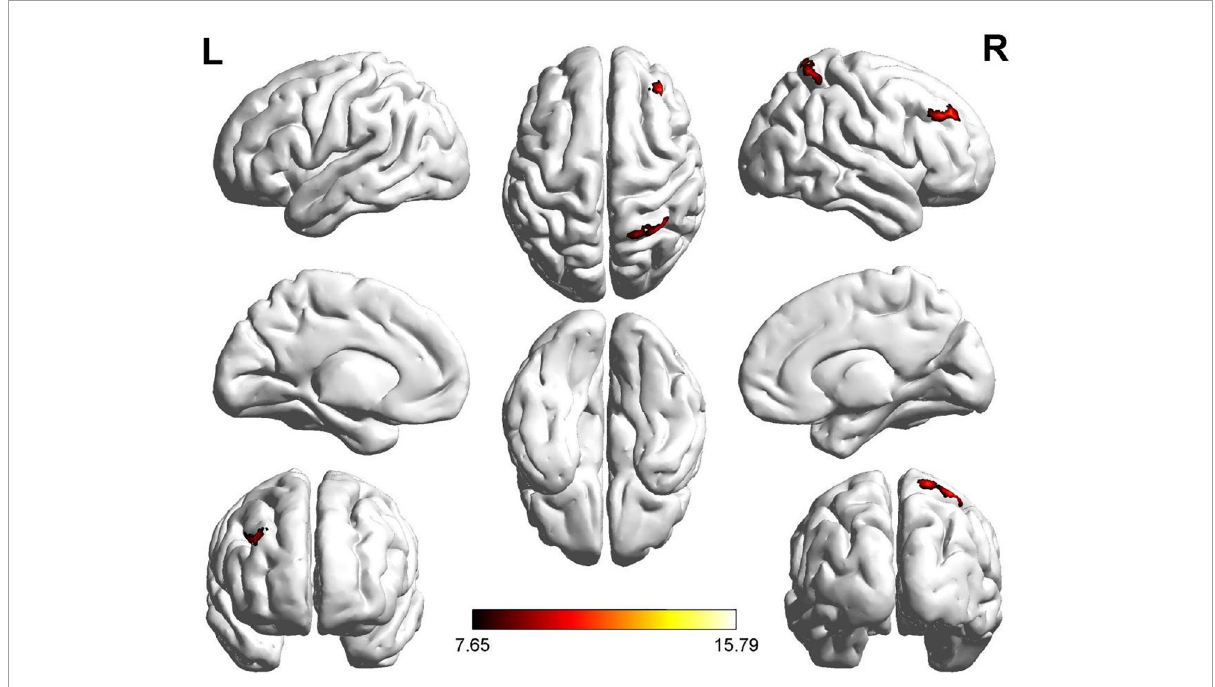
FIGURE4 Significant FC patterns were observed between the right dorsolateral SFG and the right middle frontal gyrus (MFG), right medial superior frontal gyrus (SFG), and right superior parietal gyrus (SPG) in the recent-onset tinnitus (ROT) and persistent tinnitus (PT) groups compared to the CN healthy control